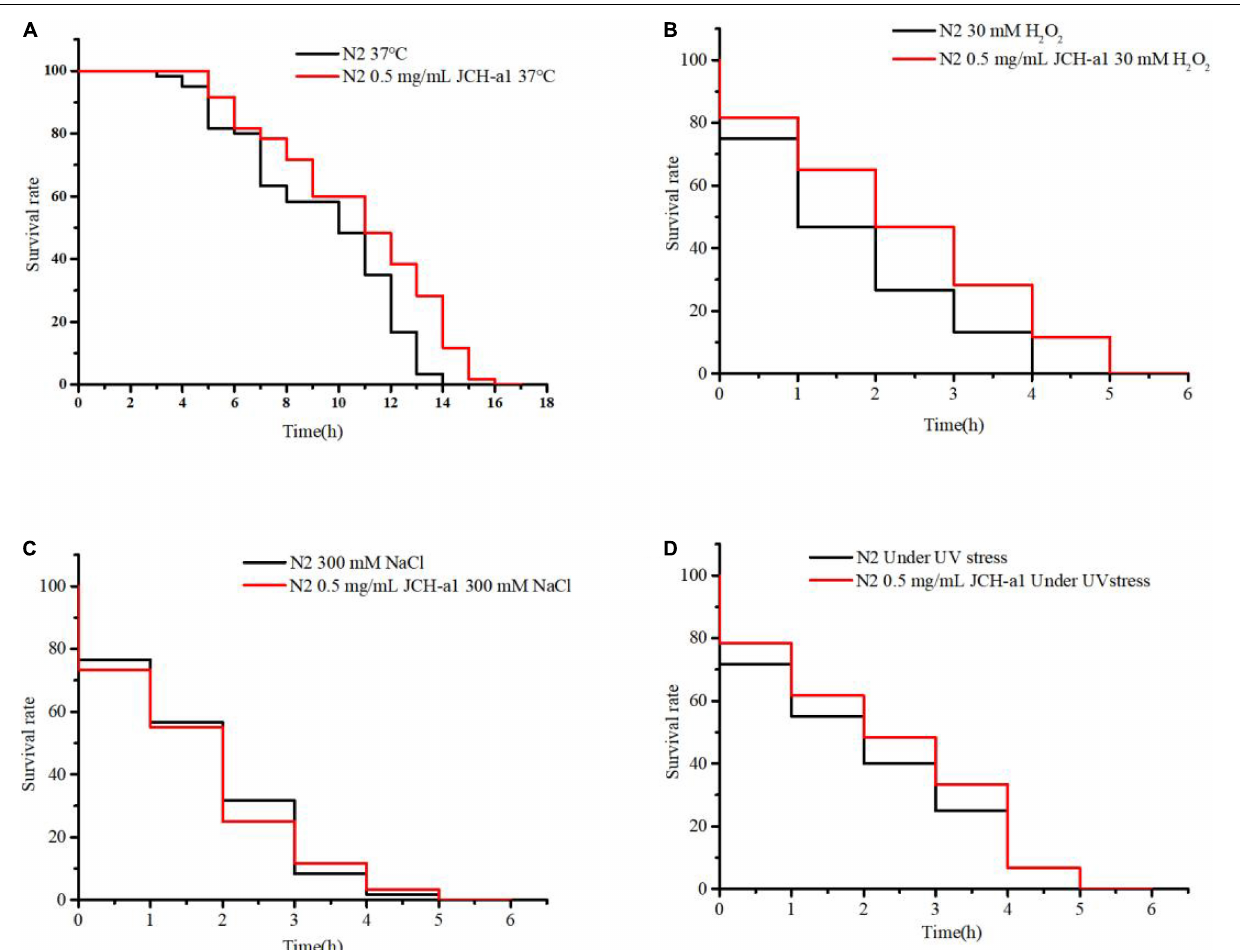
FIGURE 9 | JCH-a1 improved the health of C. elegans . (A) Survival curves of N2 with or without JCH-a1 at 37 ◦ C for heat stress. (B) Survival of N2 cultured with or without JCH-a1 in S-buffer containing 30 mM H 2 O 2 for oxidative stress. (C) Survival of N2 cultured with or without JCH-a1 in S-buffer containing 300 mM NaCl for osmotic stress. (D) Survival curves of N2 with or without JCH-a1 at UV conditions for UV